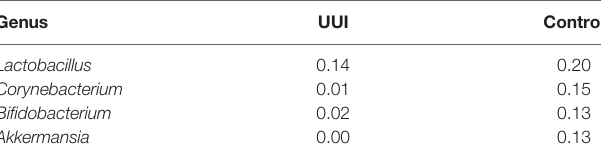
TABLE 7 | Betweenness centrality measures of key bacteria in the bladder microbiome network (de fi ned by bacteria with a betweenness score >0.10). Genus